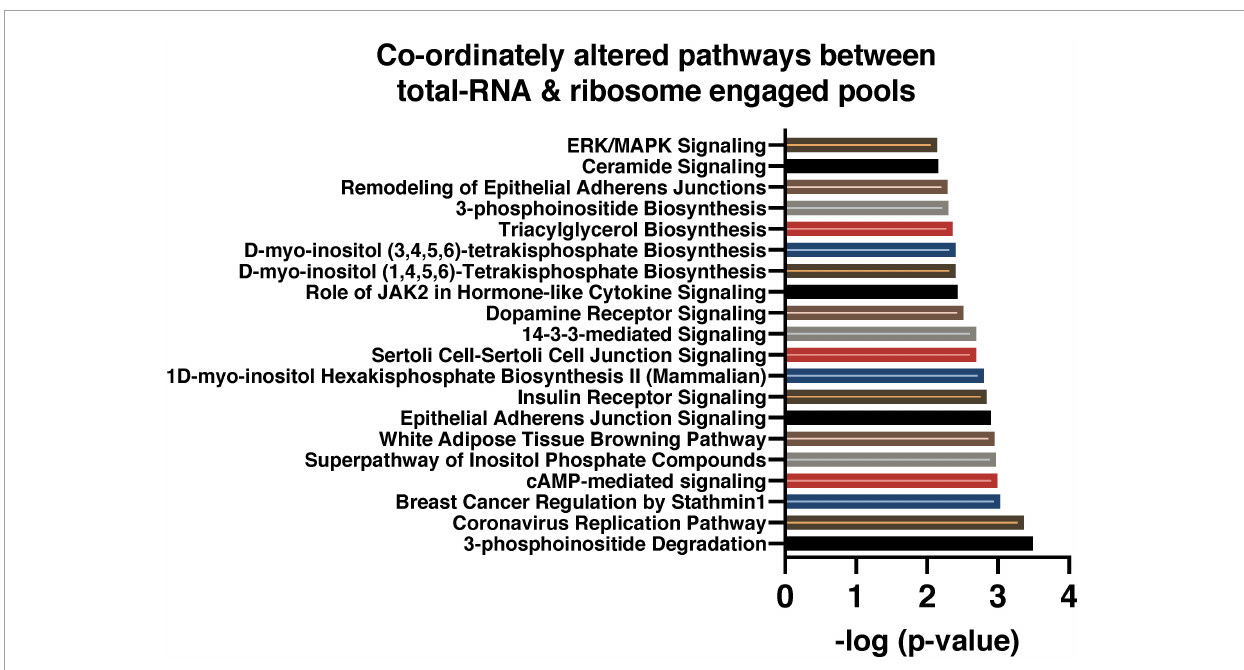
FIGURE3 Signaling pathways predicted by IPA in coordinately altered transcripts between RE and total-RNA pool. These are the top twenty canonical pathways from among the differentially expressed transcripts that were common to both RE (from TRAP-seq data) and total-RNA (from RNA-seq data), at an FDR < 0.05. The pathways are ranked according to IPA generated –log p-value